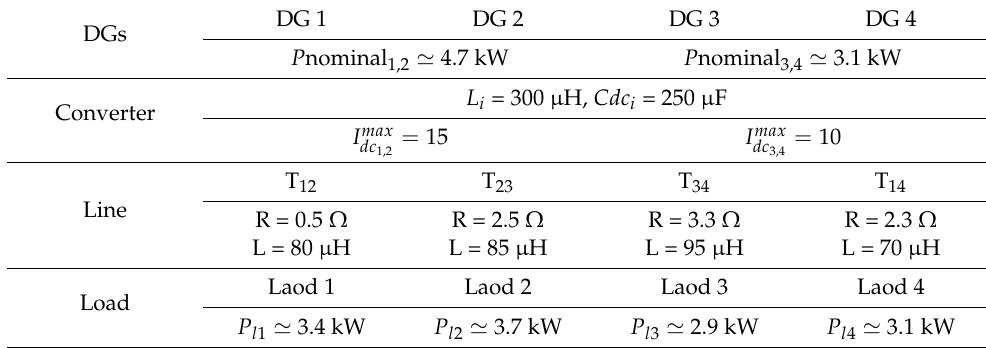
Table 1. Specifications of the testbed DCMG.